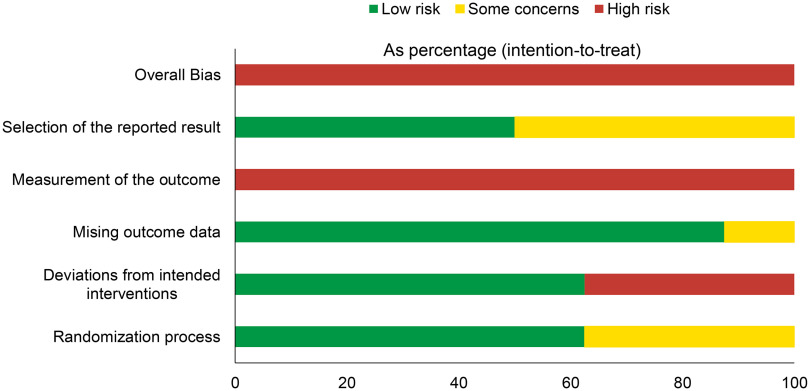
Summary of Risk of Bias of Studies of mHealth Interventions to Increase Contraceptive Uptake in Low- and Middle-Income Countries, N=8